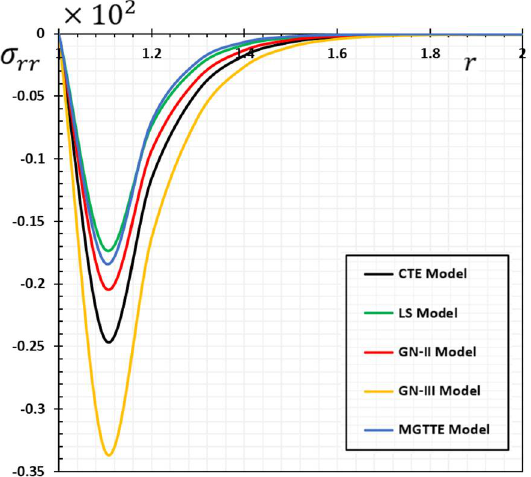
Figure 11. The radial stress, σ rr , versus different thermoelastic models.